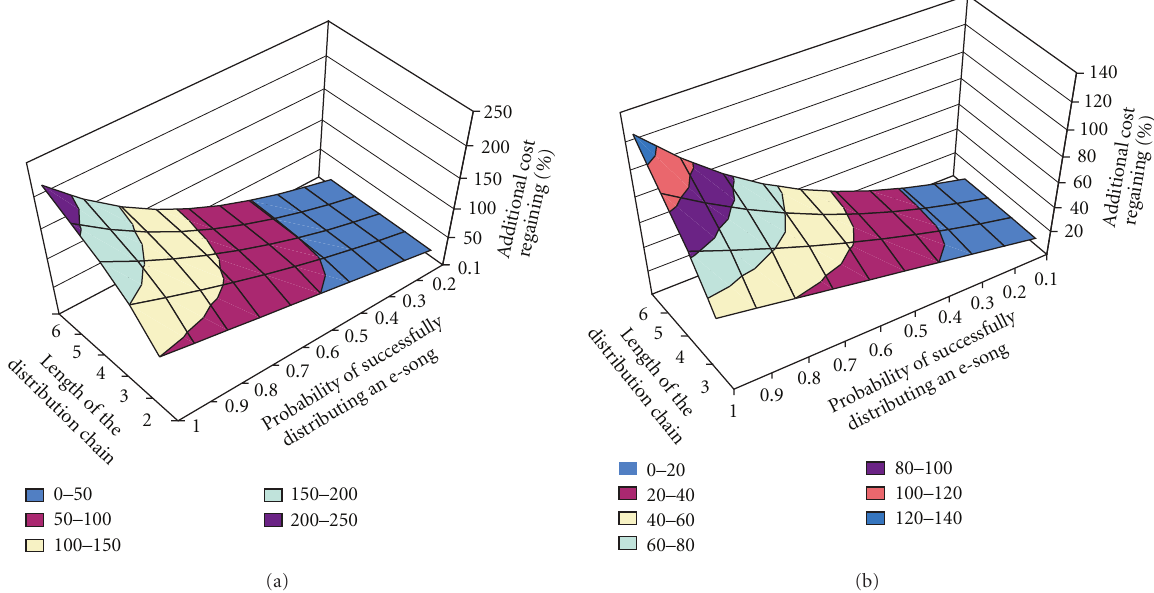
Figure 7: Additional cost regaining for the first (a) and second (b) members in the distribution chain by supposing only one friend per